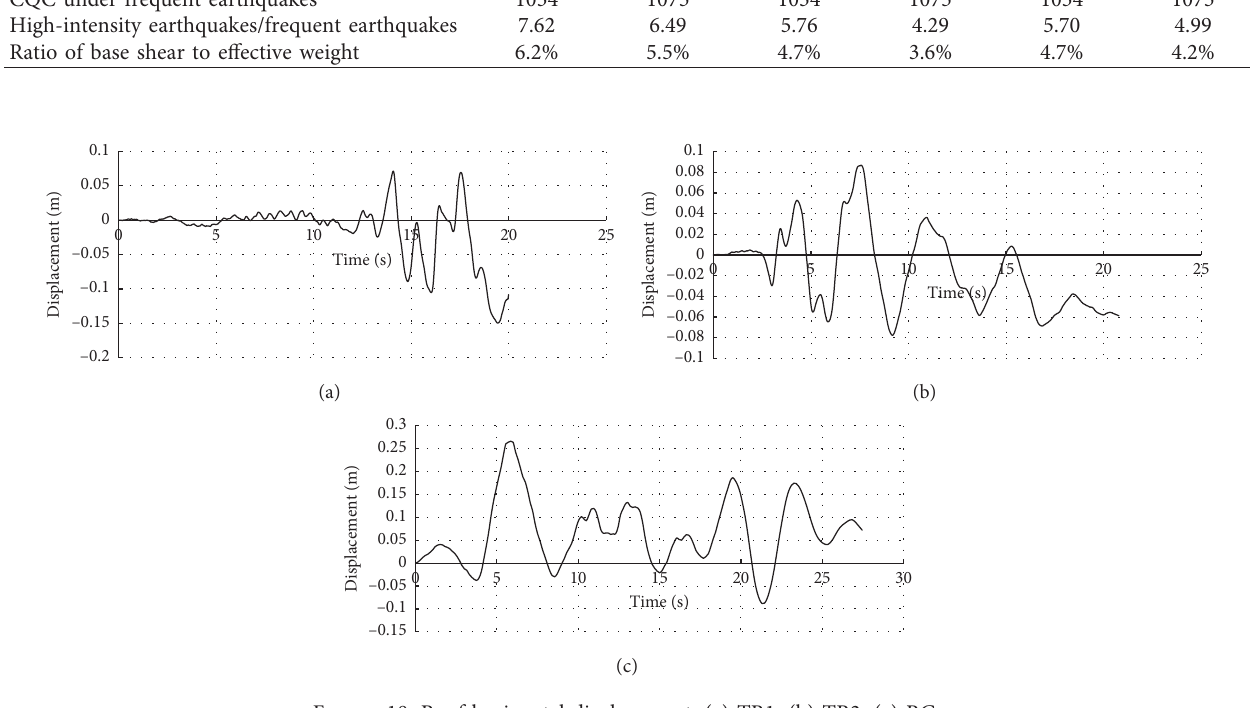
Figure 18: Roof horizontal displacement. (a) TR1. (b) TR2. (c)